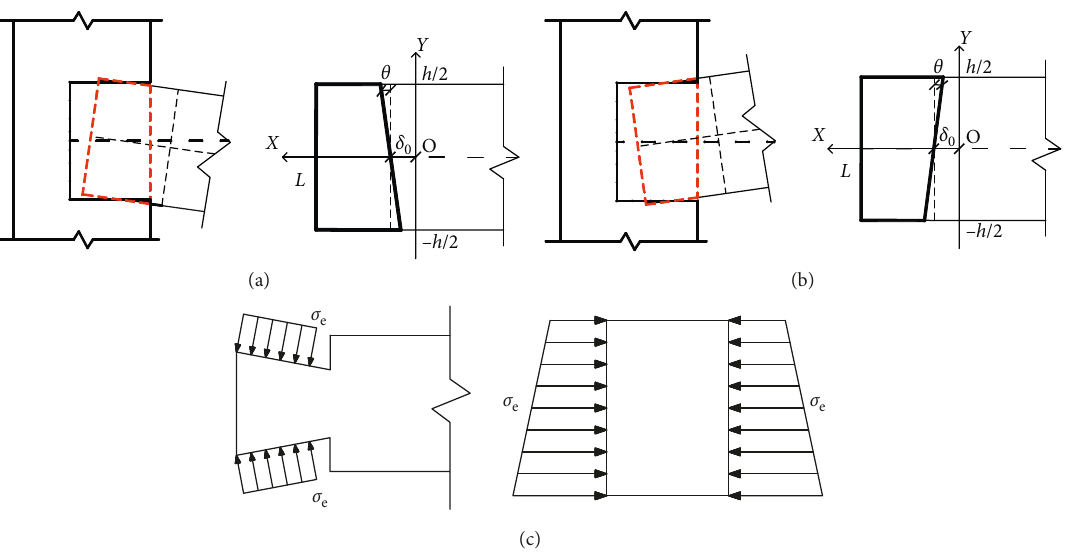
Figure 8: Tenon stress and deformation under extraction. (a) Upward loading (or unloading), (b) downward loading (or unloading), and (c) side extraction